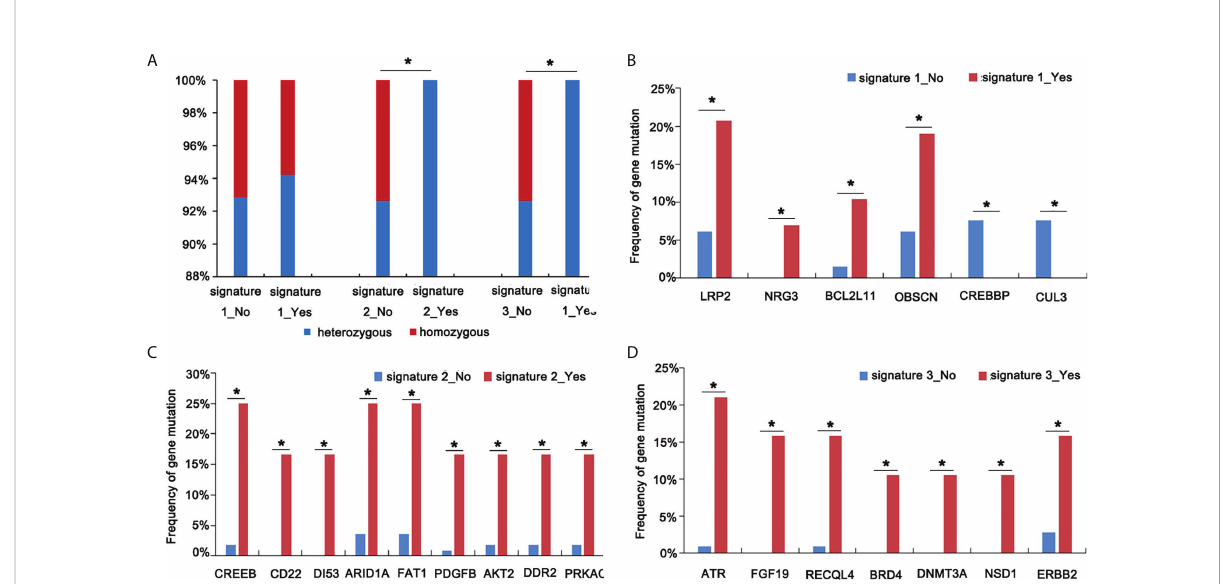
FIGURE 4 Screen mutational genes in patients having Signatures 1, 2, and 3. (A) The analysis of HLA status in patients with or without Signatures 1, 2, and 3. (B) The analysis of gene mutations in patients with or without Signature 1. (C) The analysis of gene mutations in patients with or without Signature 2. (D) The analysis of gene mutations in patients with or without Signature 3 *p < 0.05.